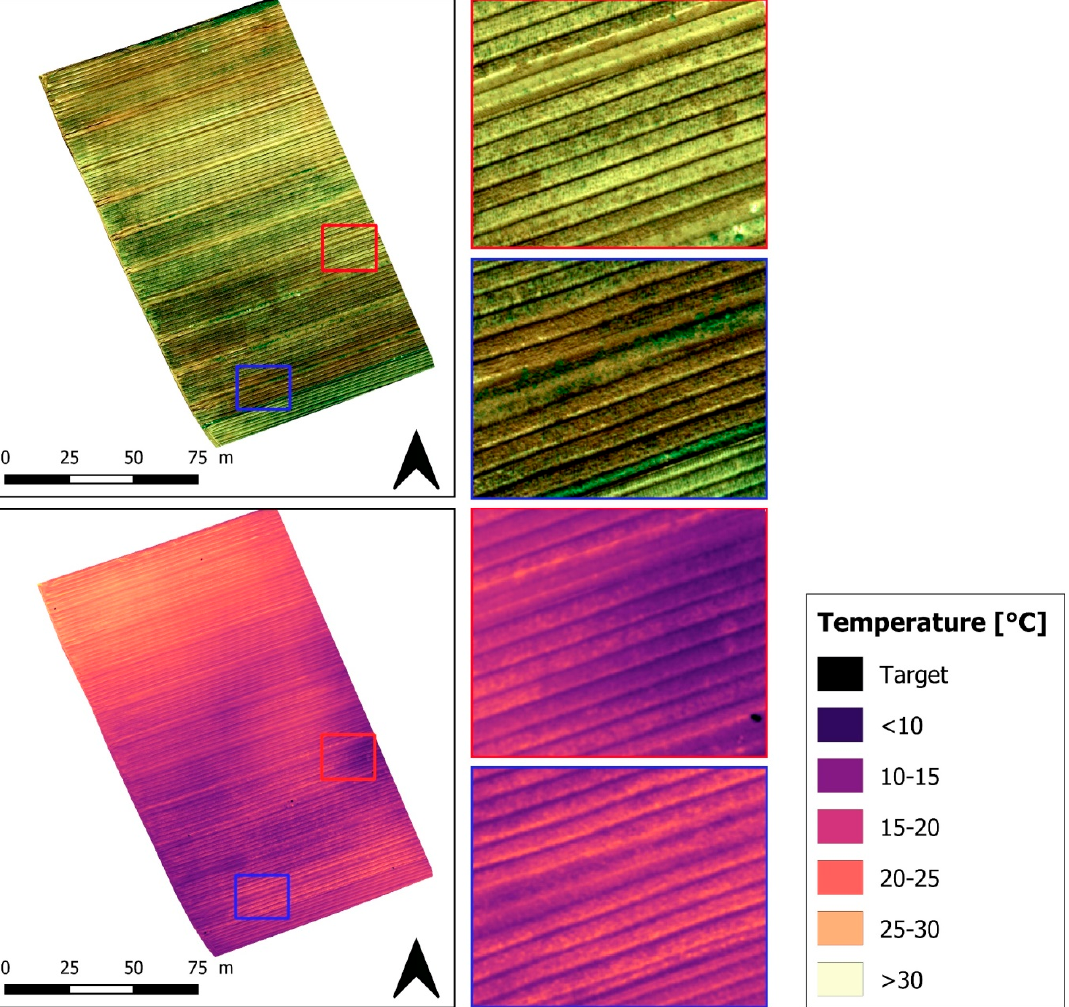
Figure 7. RGB (top) and thermal orthomosaic (bottom) images of an onion field (data collected by the authors).